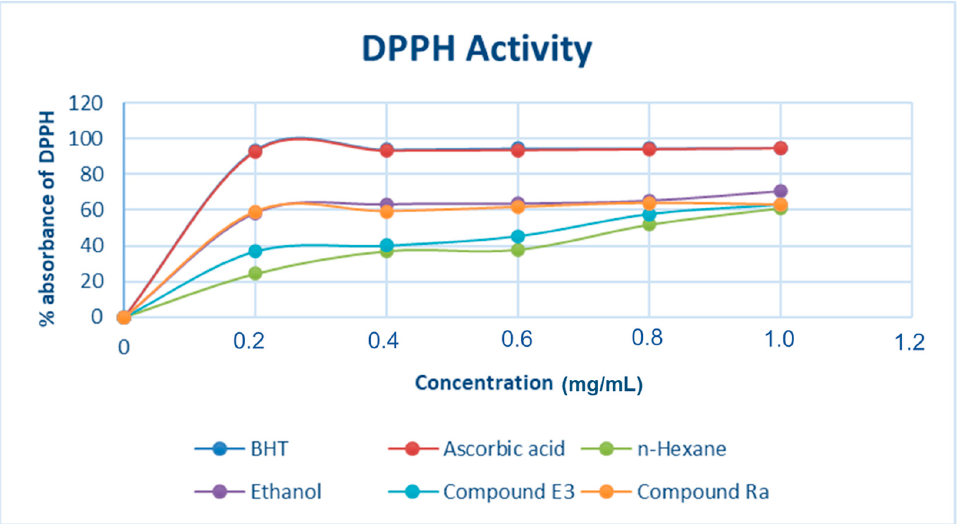
Figure 8. DPPH radical scavenging activity of M. oleifera extracts and pure compounds. Data are presented as the percentage of DPPH radical scavenging. Each value is expressed as mean ± standard deviation ( n = 3).